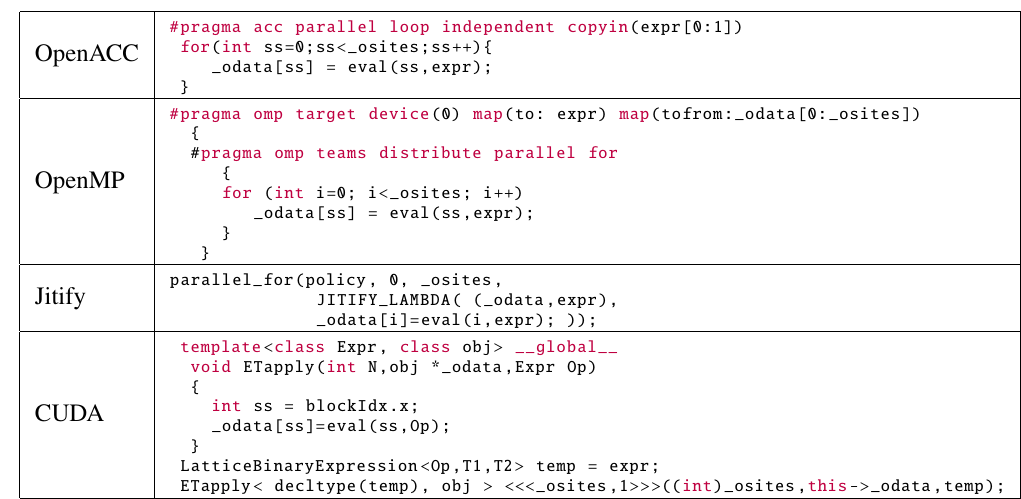
Table 1. Comparison of compute kernels in di ff erent GPU programming